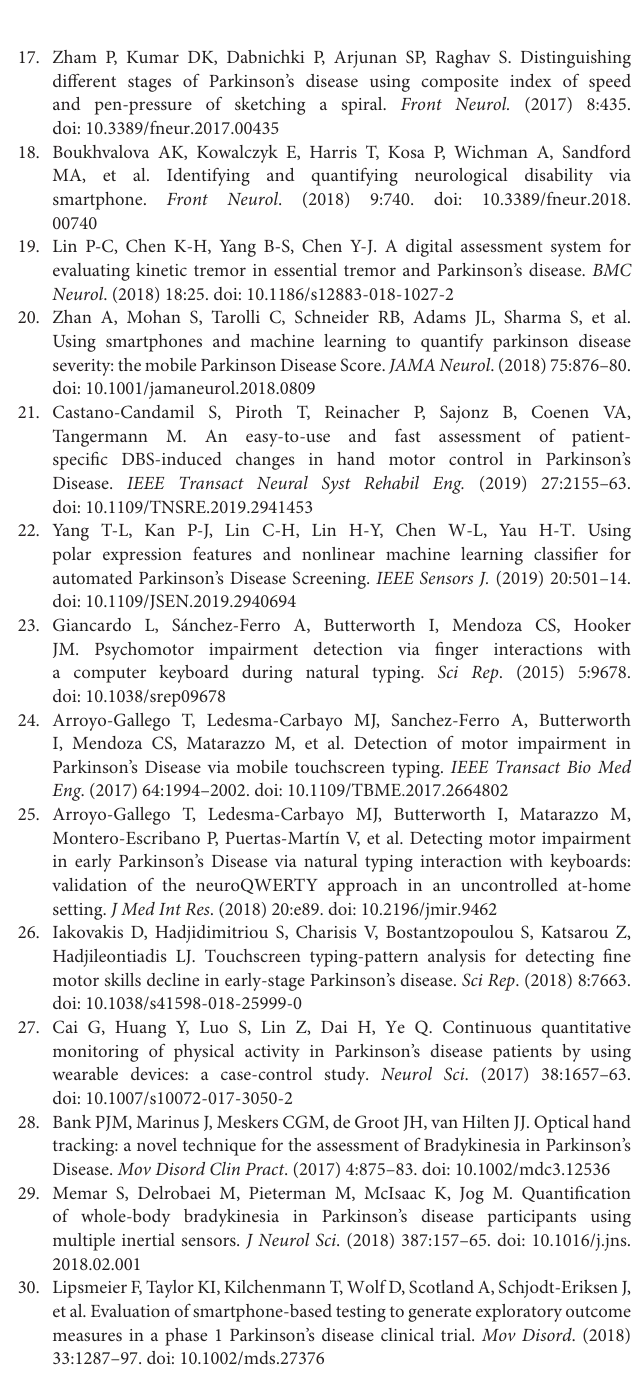
Supplementary Figure 3 | Pooled MDS-UPDRS-III scores for the dominant upper extremity also correlate to calculated MES. (A) The sum of all MDS-UPDRS-III score components from each patient’s dominant upper extremity (DUE) were plotted with corresponding, session-wide MES means for 24 patients with PD. Spearman’s correlation coefficient (red line) and corresponding p -values (blue line) and were calculated using percentiles between 0 and 100 of session-wide MES per patient. Dotted line indicates a p -value of 0.05, the selected alpha-level in this analysis. The maximum strength of correlation and